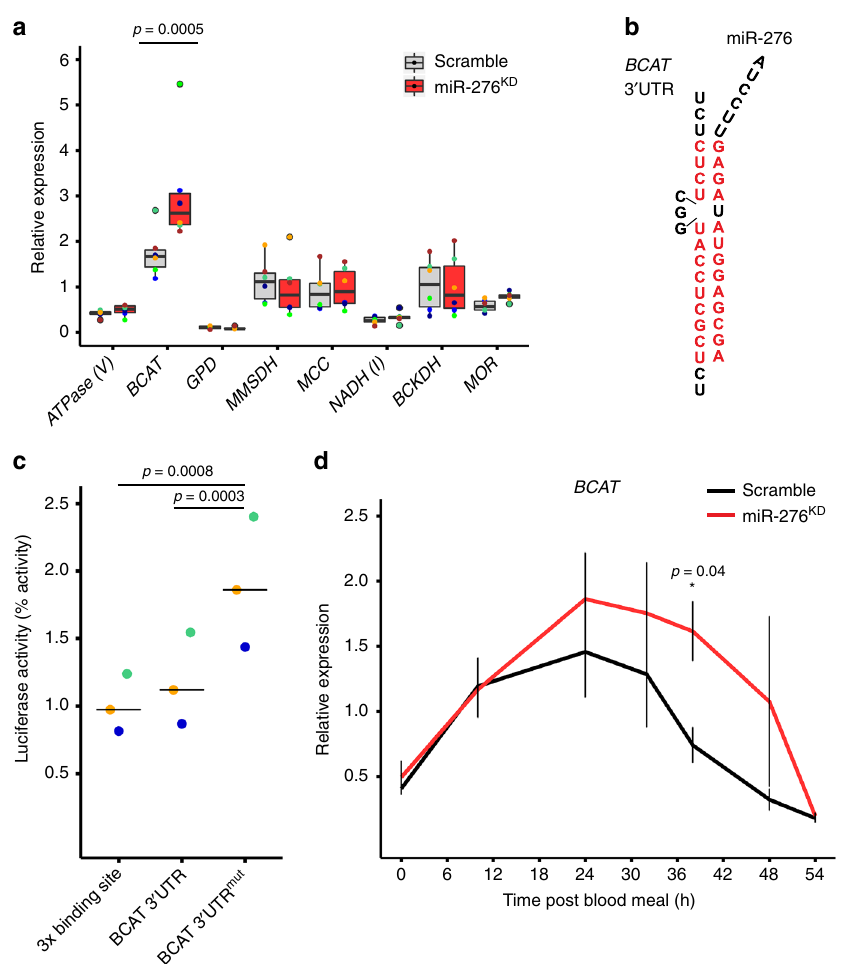
Fig. 2 miR-276 post-transcriptionally represses the branched-chain amino acid transferase in the mosquito fat body. a Expression of predicted miRNA targets at 38 h post blood feeding in the fat body of mosquitoes ( n = 5, N = 6) injected with anti-miR-276 (miR-276, red) or scrambled antagomir (scramble, gray). Expression of the ATP synthase (ATPase V) , branched chain amino acid transferase ( BCAT ), glycerol-3-phosphate dehydrogenase ( GPD ),